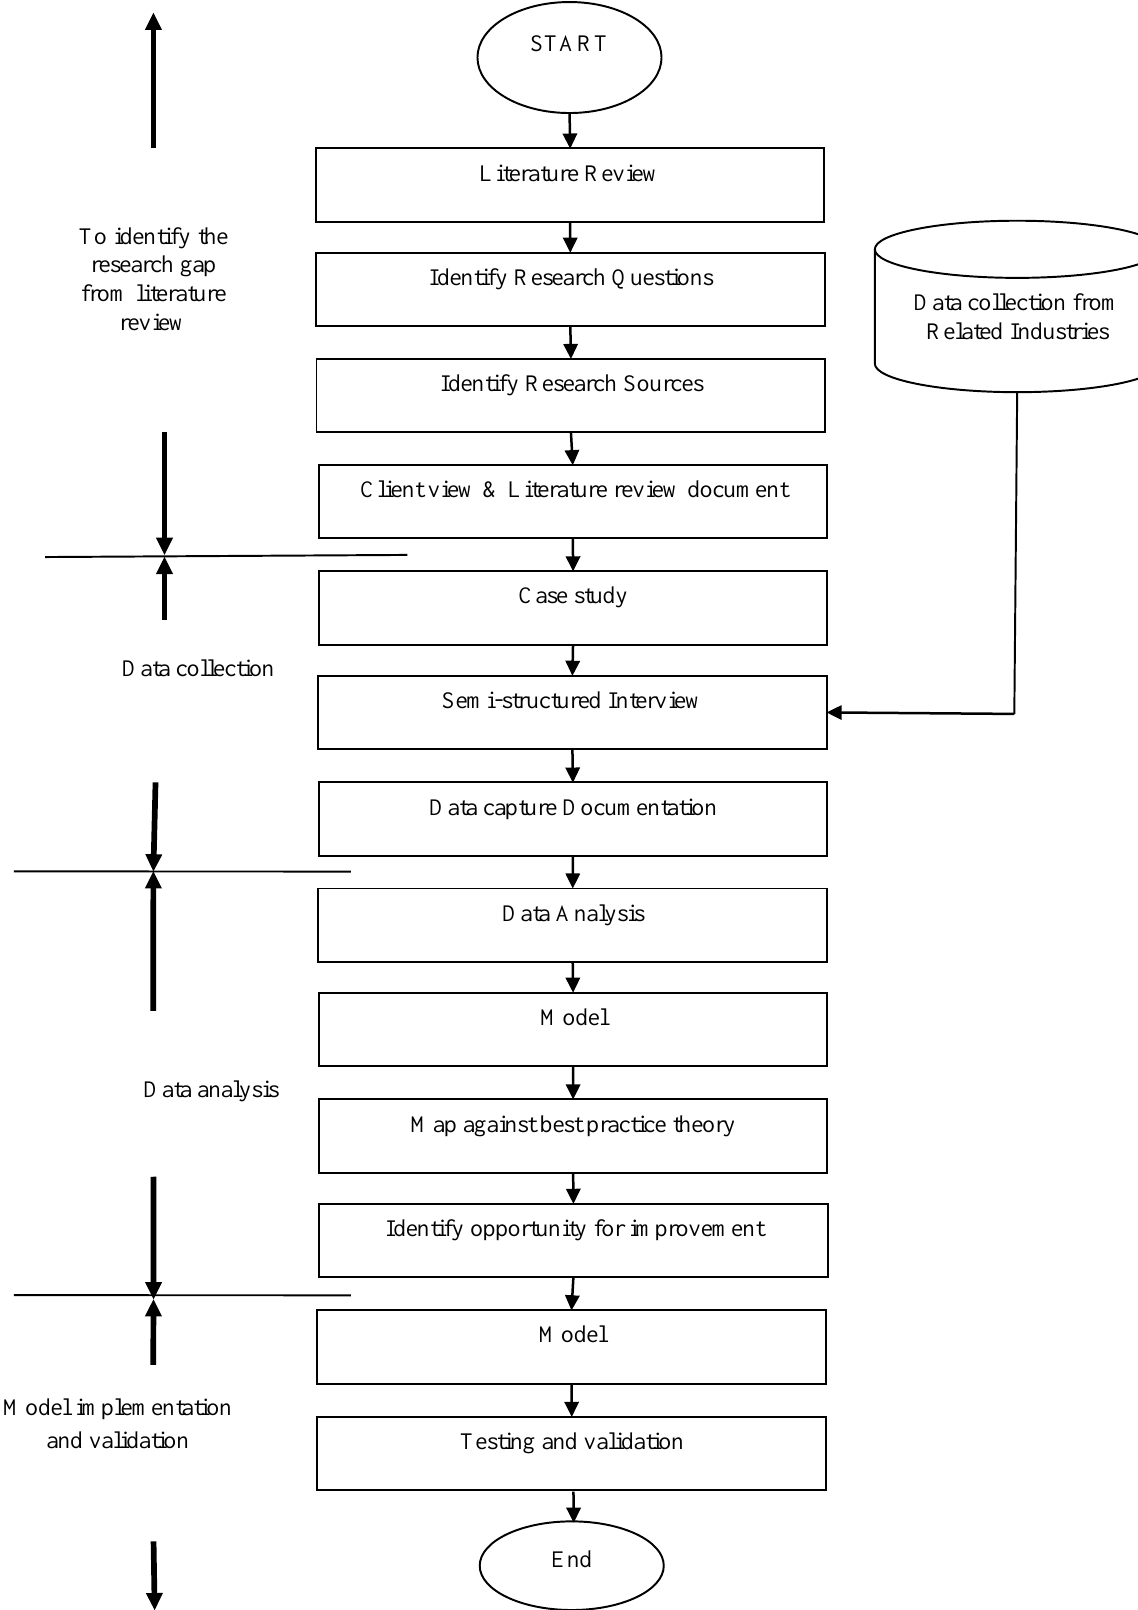
Fig. 7. Flow chart of research